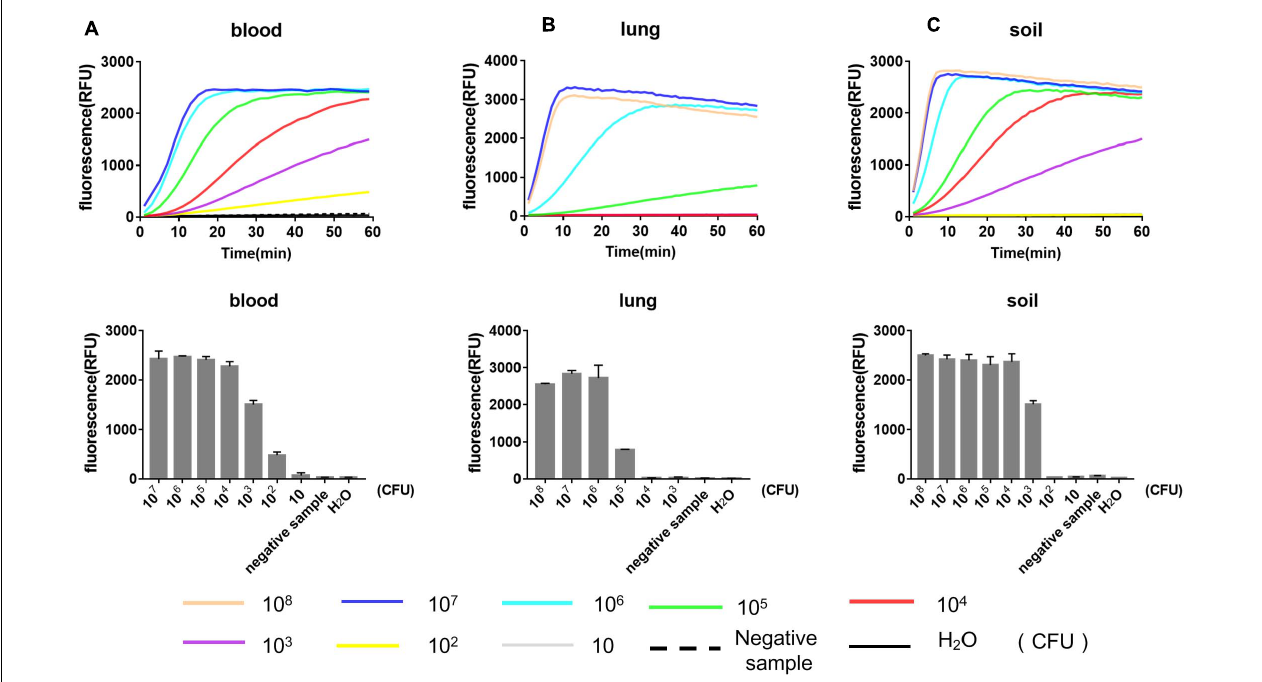
FIGURE 4 | Performance of RPA-Cas12a for the detection of Y. pestis -spiked environmental and tissue samples. Results for the mouse blood samples (A) , lung tissues (B) , and soil samples (C) spiked with Y. pestis ranging from 10 1 to 10 7 CFU. For preparation of the spiked samples, 100 µ l of mouse blood, 100 µ l of lung homogenate (containing 20 mg of mouse lung tissues), and 100 mg of soil were used as the sample matrix. Real-time curve shows the fluorescence signals taken every minute within 1 h. Bar graphs show the endpoint fluorescence intensities detected at 1 h of detection. Data are represented as mean with SD ( n = 3). RPA, recombinase polymerase